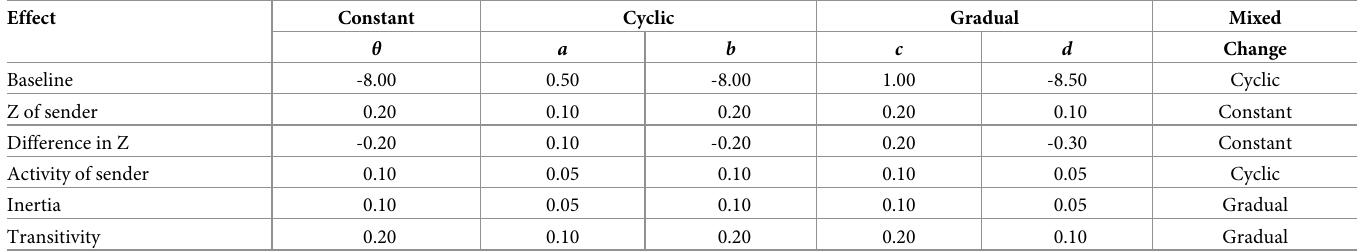
Table 2. Information on the model parameters in the four scenarios for time-varying effects.